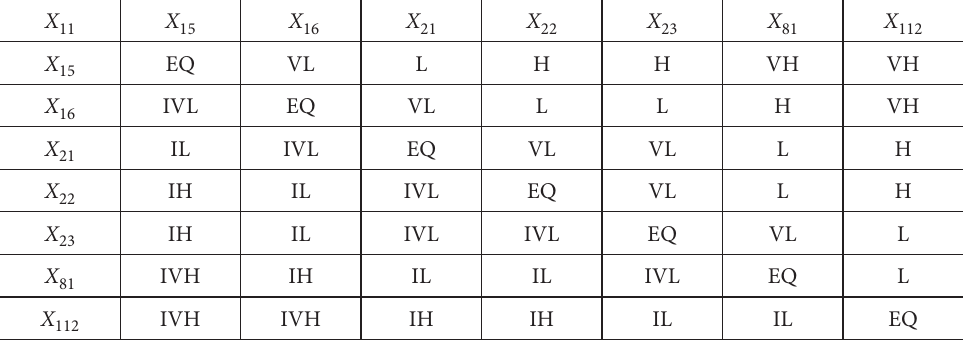
Table 6. Pair-wise comparison with linguistic scale